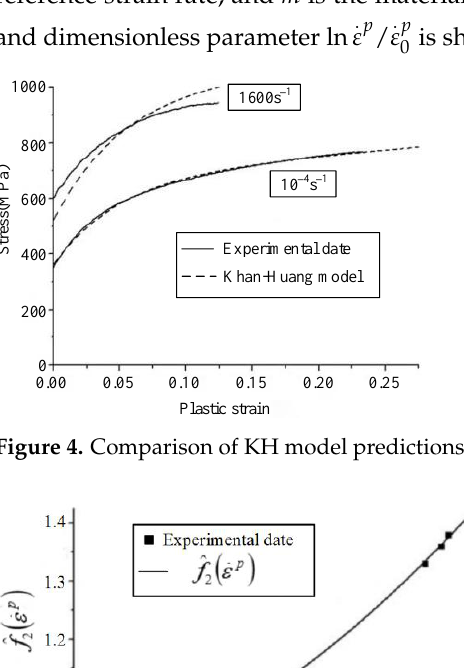
. p ε is the 0 (cid:16) . ˆ p (cid:17) f ε 2